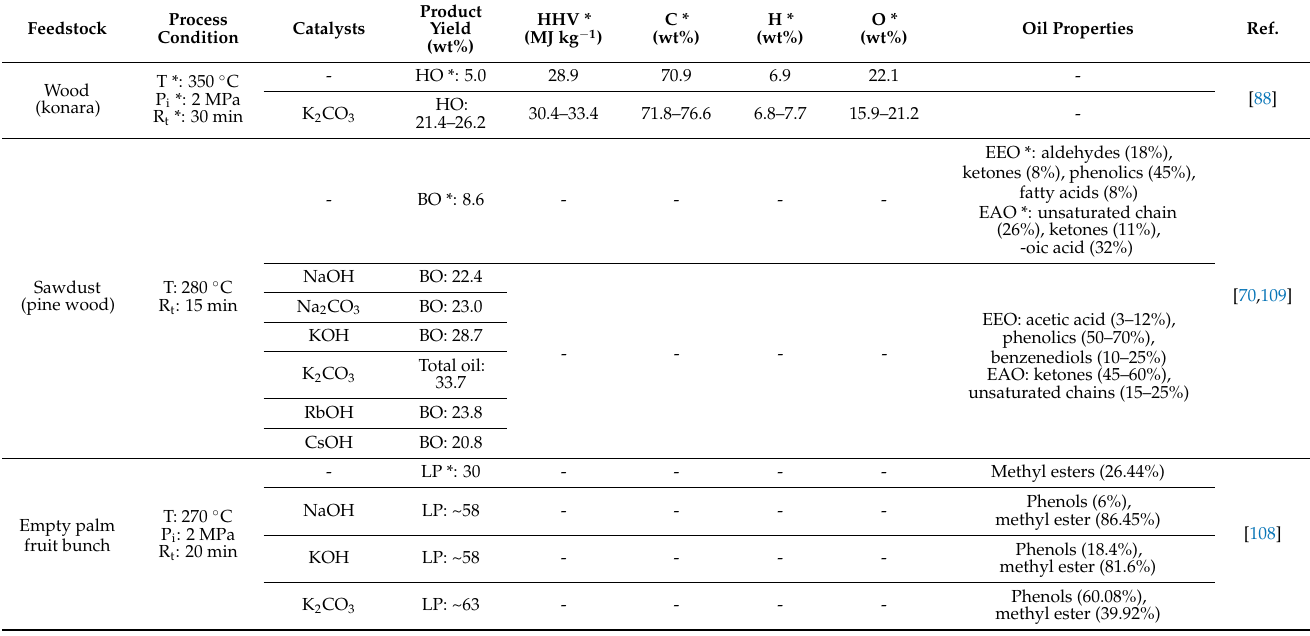
Table 9. Effect of catalyst during HTL